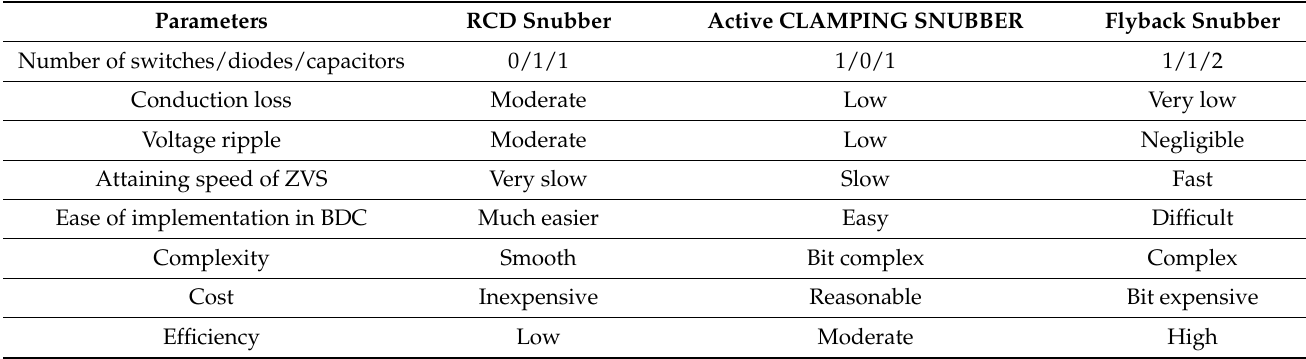
Table 1. Comparative analysis of various snubber